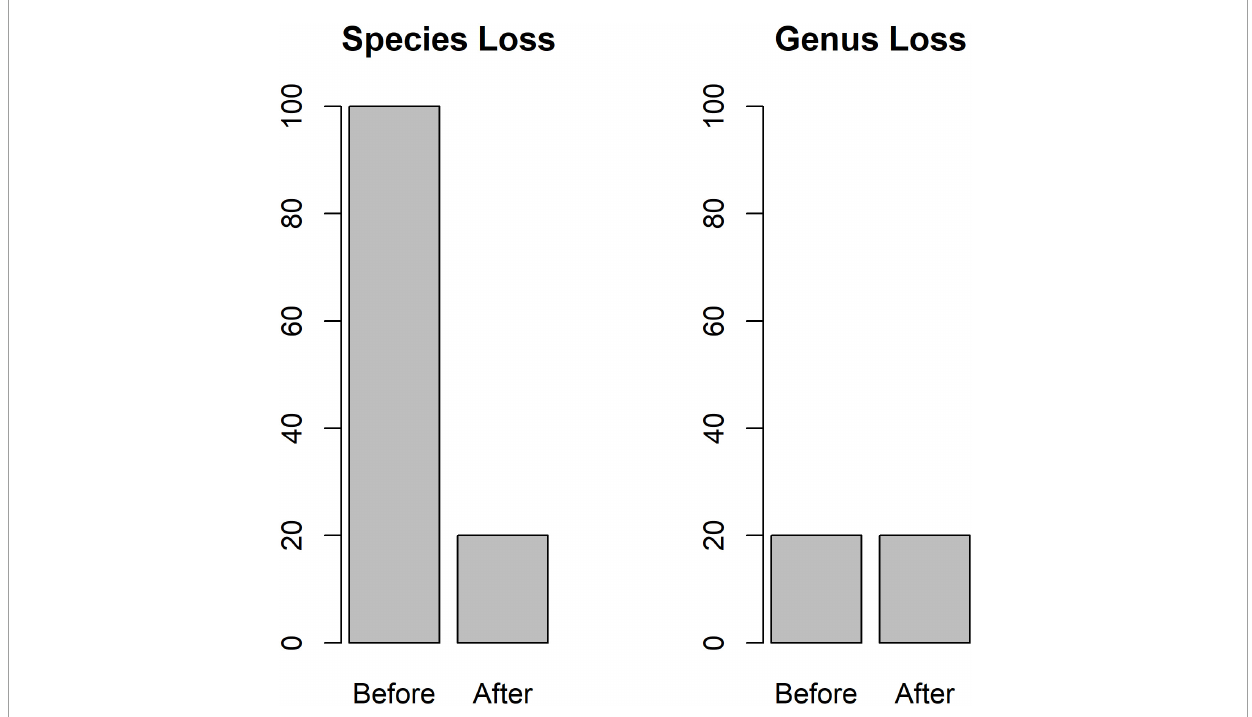
FIGURE2 In a hypothetical stream system with 100 species equally distributed across 20 genera, up to 80% of the species could be extirpated before biodiversity loss is registered by genus level analyses.